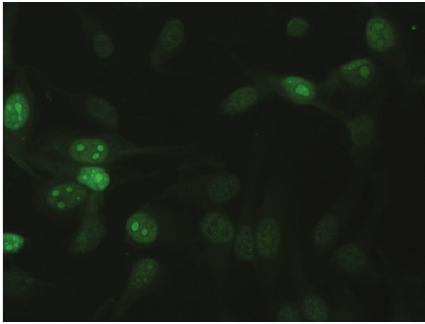
Figure 2: IIF on HEp2 cells: speckeld and nuclear and nucleolar staining (anti-SSA/Ro antibodies). Dilution 1: